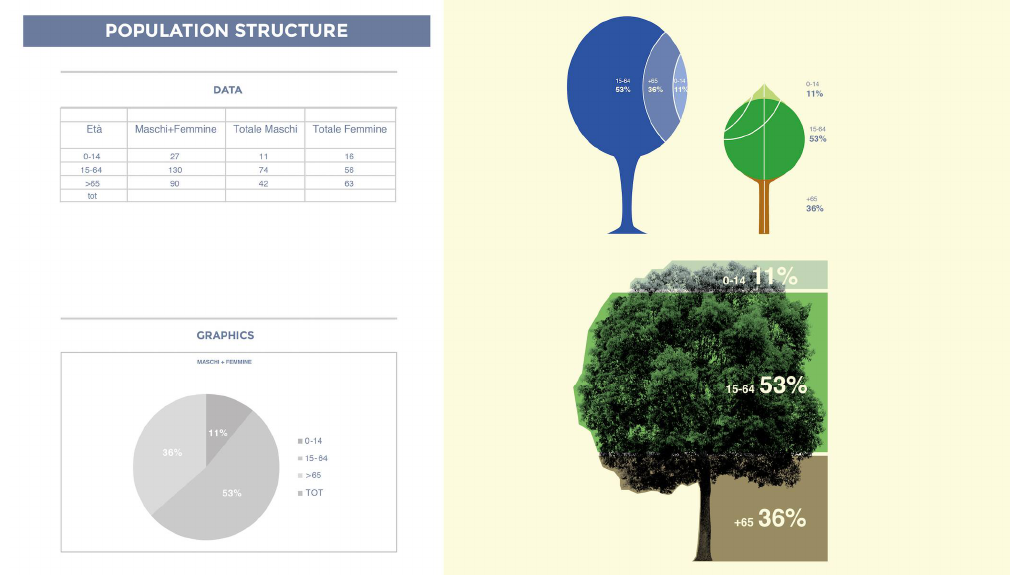
Figure 4. Representing the population structure for three age groups in 2017.